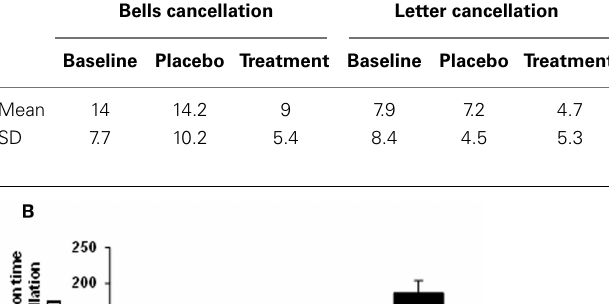
Table 3 | Performance on individual cancellation tasks.